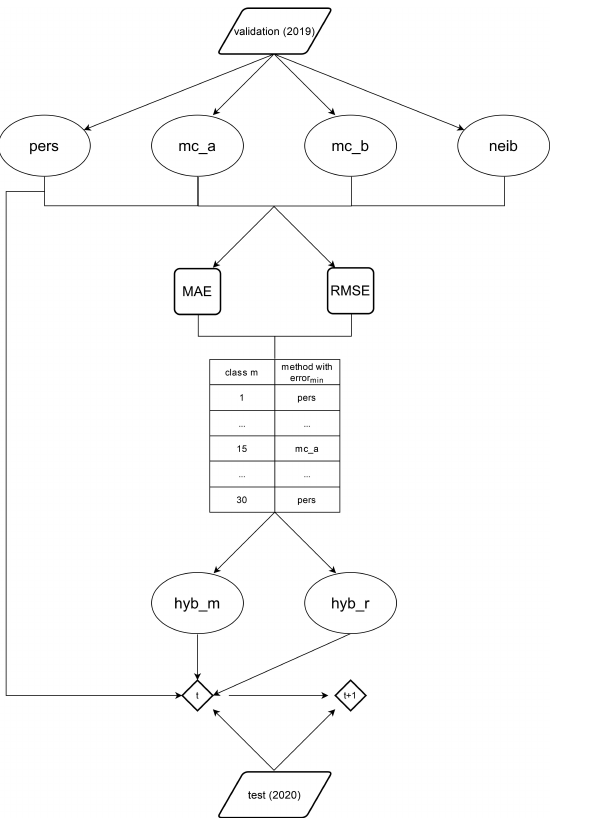
Figure 8. Flux diagram illustrating the hybrid approach. The indices of the methods can be found in Table